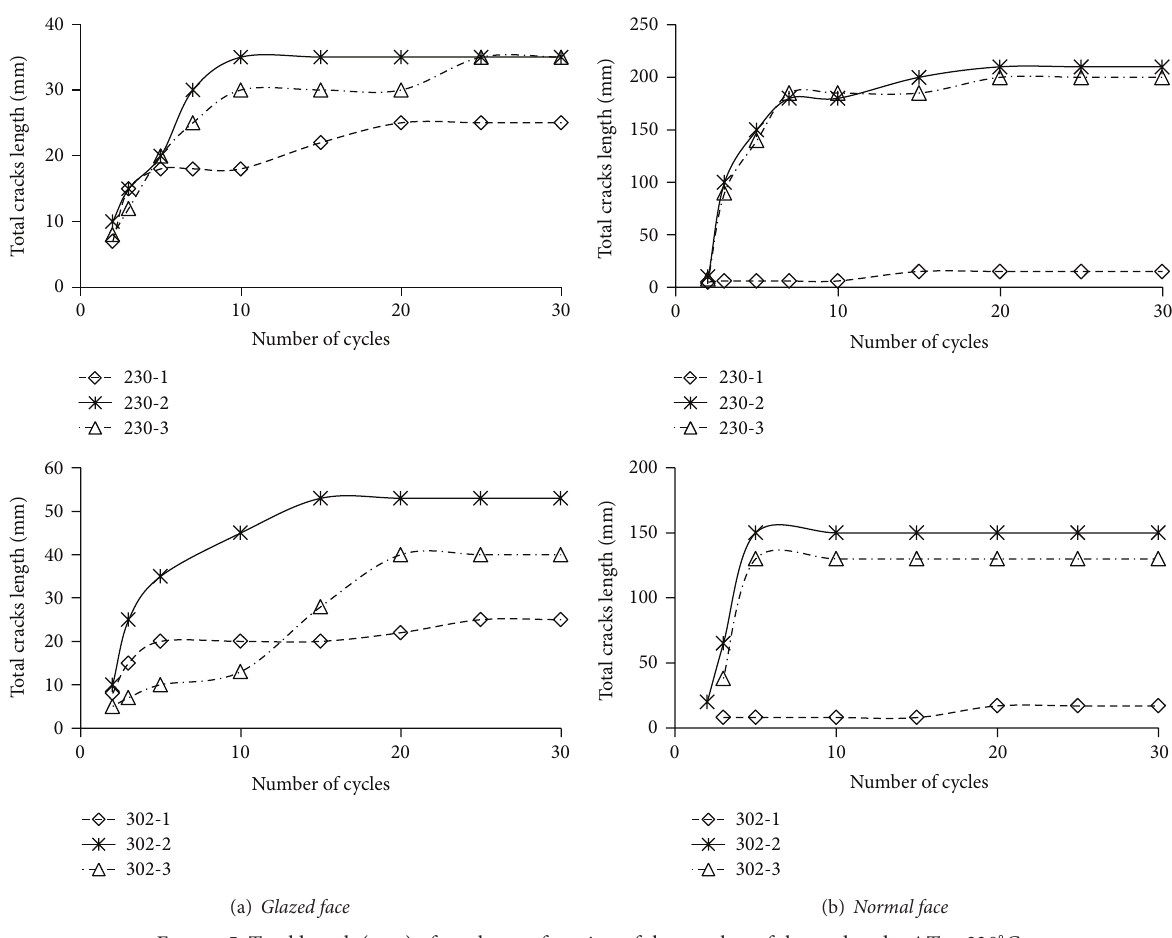
Figure 5: Total length (mm) of cracks as a function of the number of thermal cycles Δ𝑇 = 23 0 ∘ C. Table 4: Damage of the studied grades by thermal shocks at Δ𝑇 = 230 ∘ C.